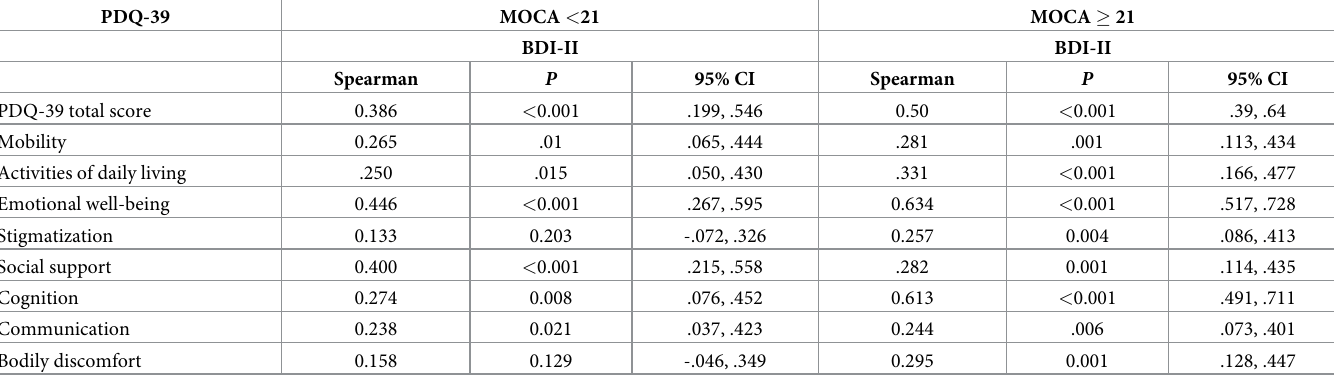
Table 3. Convergent validity of the Parkinson’s Disease Questionnaire-39 in people with low and high Montreal Cognitive Assessment scores.